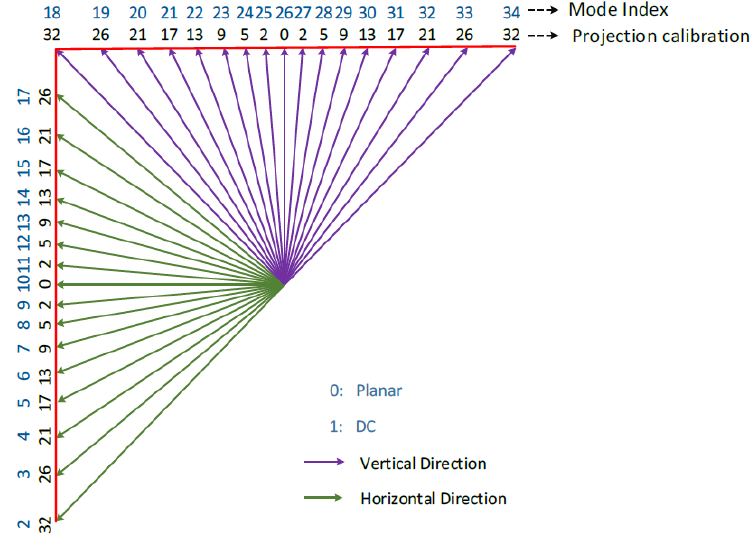
Figure 11. Intra-prediction modes in High-efficiency video coding (HEVC) [29].